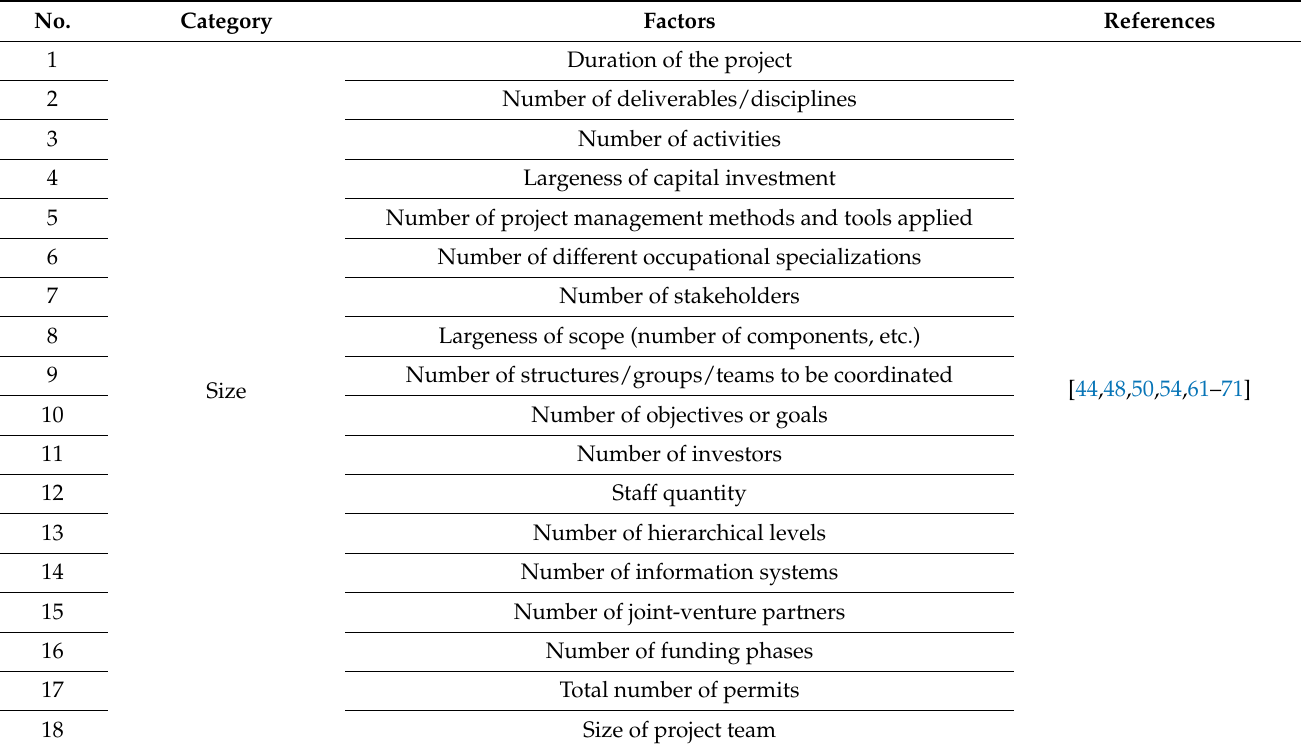
Table 2. General categorization of project complexity factors in the construction industry based on the literature